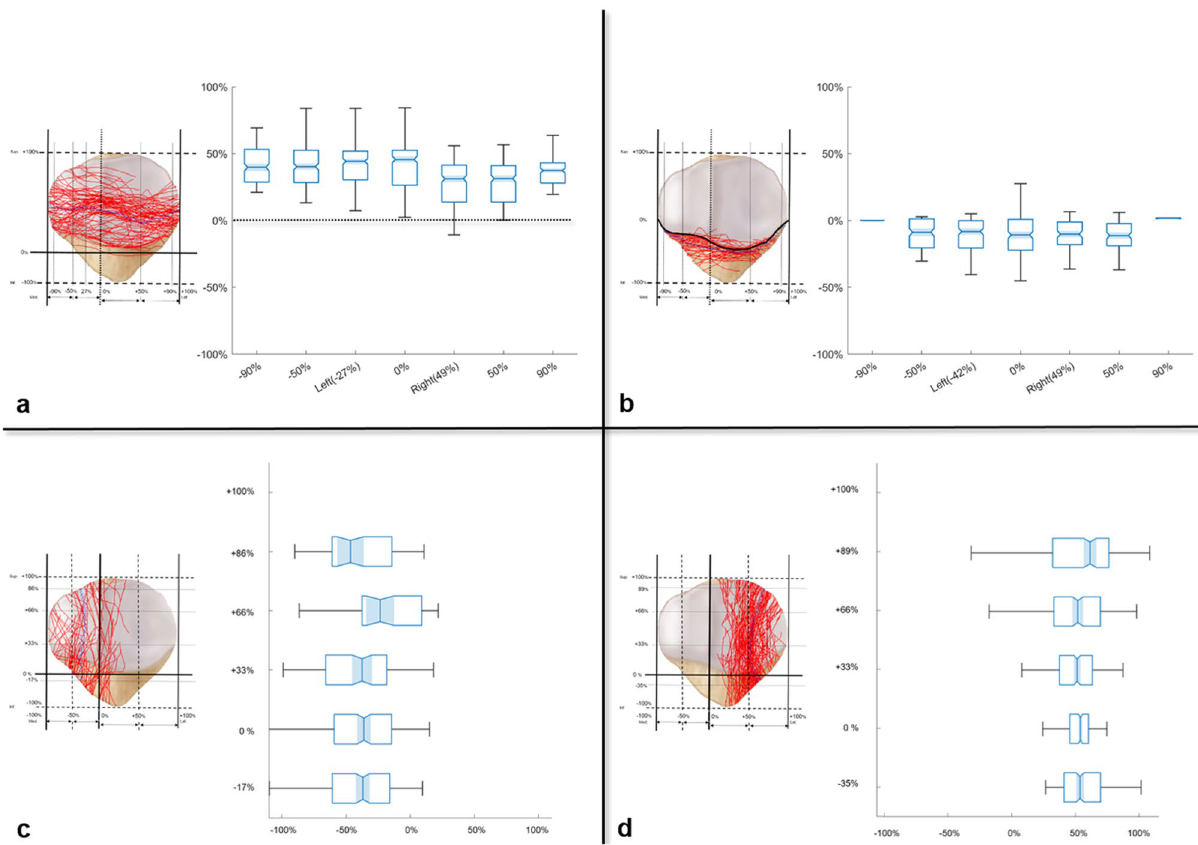
Figure 6. The distribution and the quantification of each fracture line, The average value of the primary horizontal fracture line runs ranged from + 27.9 to + 42.1% of the entire articular surface ( a ). The average value of the secondary horizontal fracture line was located within + 1.91 to − 12.6% from the inferior boundary of the articular facet ( b ). The average value of medial secondary vertical fracture line runs from − 52.2 to − 43.6% of a medial articular facet ( c ). The average value of lateral secondary vertical fracture line was located within + 27.4 to 44.6% of a lateral articular facet ( d